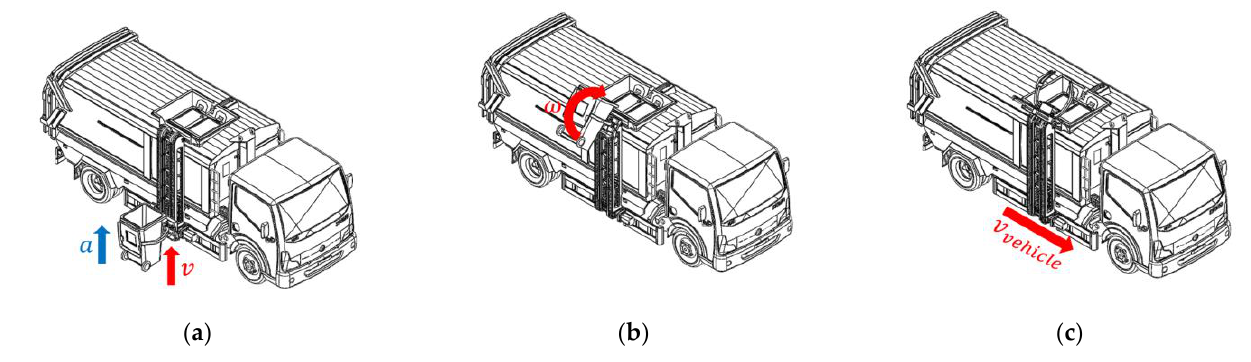
Figure 10. Three typical load cases: ( a ) load case A; ( b ) load case B; ( c ) load case C. The value of the truss structure load under three load cases are shown in Table 4. Table 4. The value of the truss structure load.